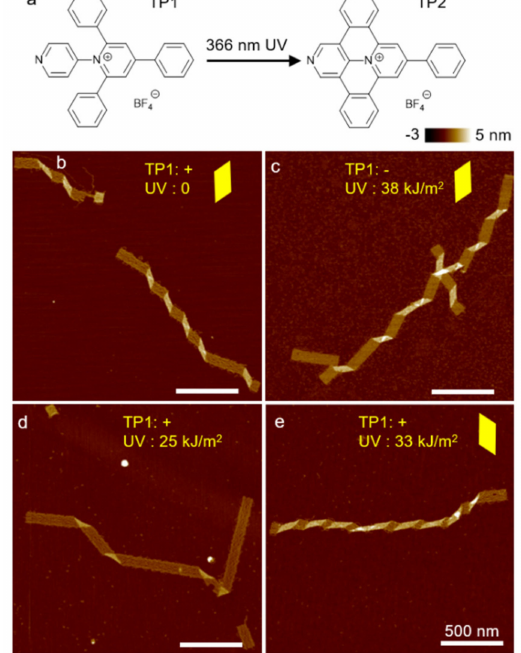
Figure 5. ( a ) Chemical structure of photoswitchable intercalator: TP1 and TP2. TP1 does not associate with DNA. UVA converts TP1 to TP2, which is a strong DNA intercalator. ( b – e ) AFM images of origami ribbons with and without TP1 and UVA radiation. ( b , c ) If one of the two components is absent, there is no change in the origami structure. ( d , e ) Conformation change occurs only when both TP1 and UVA are present simultaneously. ( d ) Partial conversion of TP1 to TP2 flattens DNA structures. ( e ) Complete conversion can change the DNA helicity significantly, causing a flip of twist handedness. Yellow parallelograms highlight the shape of the kinks, suggesting twist-handedness. (Contents in this figure were previously published. Adapted with permission from [60]. Copyright (2017) American Chemical Society. Further permissions related to the material excerpted should be directed to the